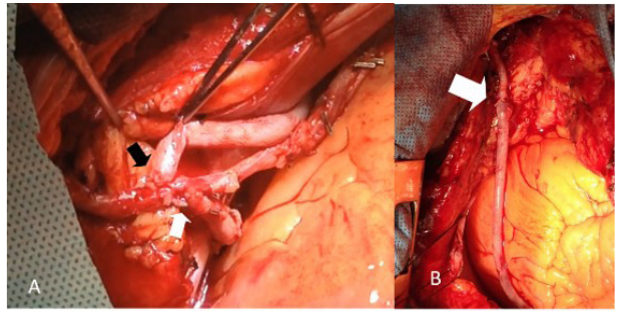
Fig. 2 - A. The free right internal thoracic artery (RITA) to obtuse marginal (white arrow) and saphenous vein graft to diagonal (black arrow) proximally anastomosed to the left internal thoracic artery to left anterior descending artery in a Y-configuration. B. Vein graft to posterior descending coronary artery proximally anastomosed to the RITA stump (white